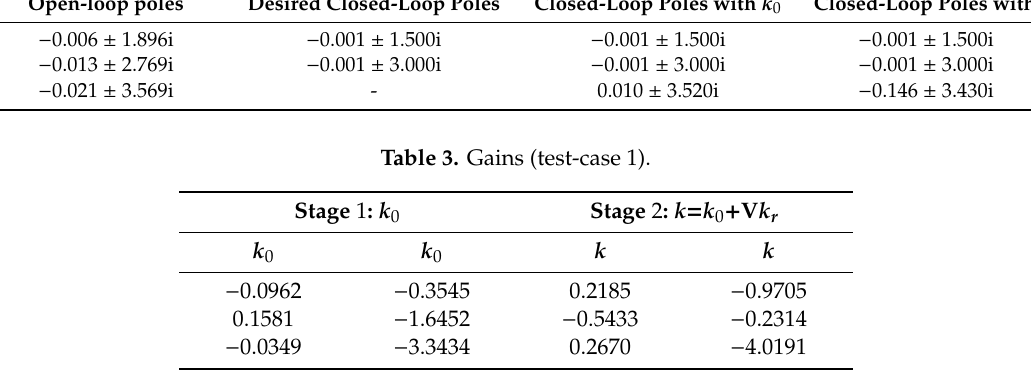
Figure 2. Open-loop and closed-loop poles of the three-mass system (test-case 1). Table 2. Open-loop and closed-loop poles (test-case 1).